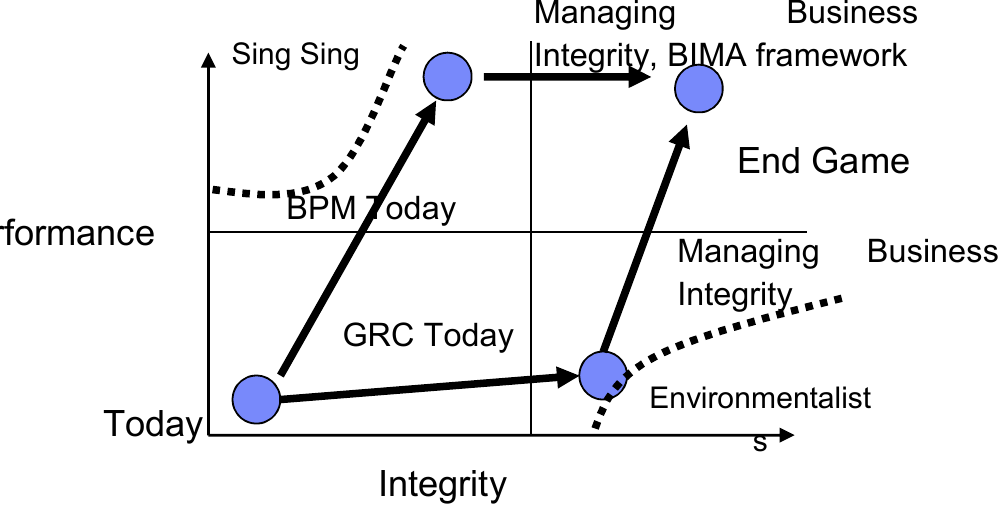
Figure 1. Relationship between business integrity and performance.